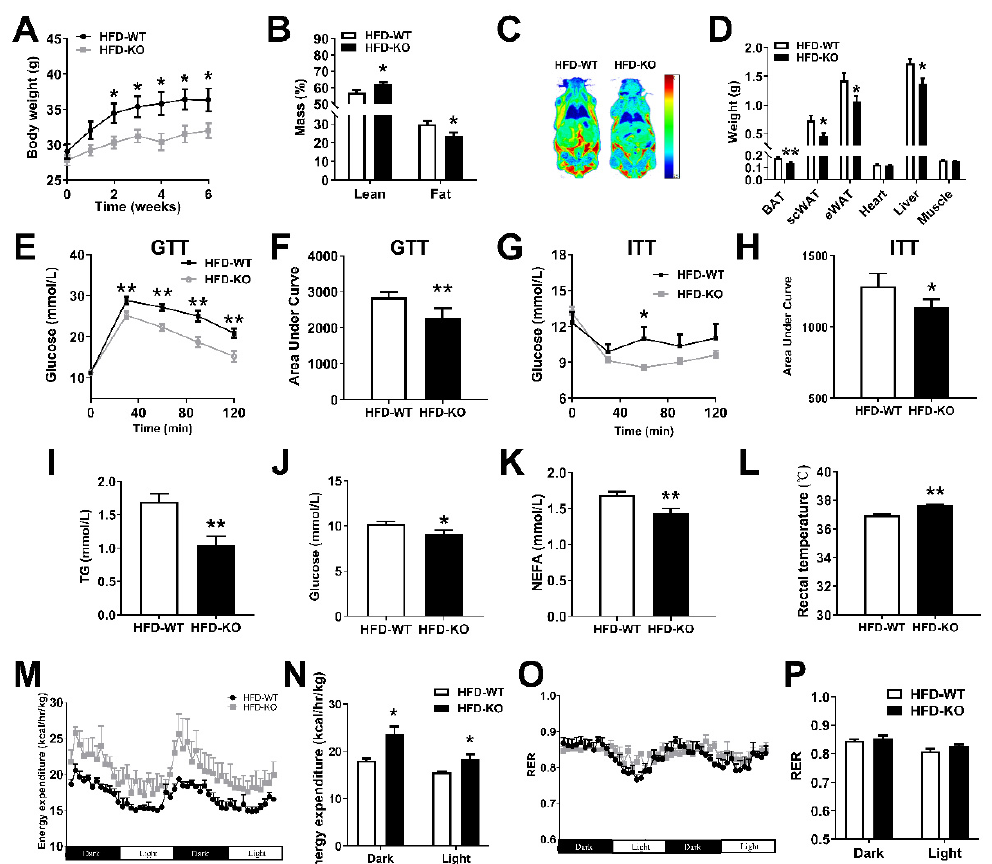
Figure 4. miR-143KO reduced HFD-induced obesity by increasing energy expenditures in BAT. ( A – D ) Body weight of WT and KO mice fed HFD (n = 8). ( B – D ) fat mass ( B ), quantitative magnetic resonance ( C ), and organ weight ( D ) in WT and KO mice fed HFD for 16 weeks (n = 8). ( E – H ) The glucose tolerance test (n = 12) and insulin tolerance test (n = 8) of mice fed HFD for 10 days. ( I – K ) The TG, glucose, and NEFA levels of serum of mice fed HFD for 16 weeks (n = 8). ( L ) The rectal temperature of WT and KO mice fed HFD for 16 weeks (n = 8). ( M – P ) Energy expenditure and RER of 8-week-old WT and KO mice fed HFD for 10 days (n = 4). Data are presented as the mean ± SEM. * p < 0.05 vs. controls; ** p < 0.01 vs. controls, as determined by a two-tailed unpaired Student’s t - test.